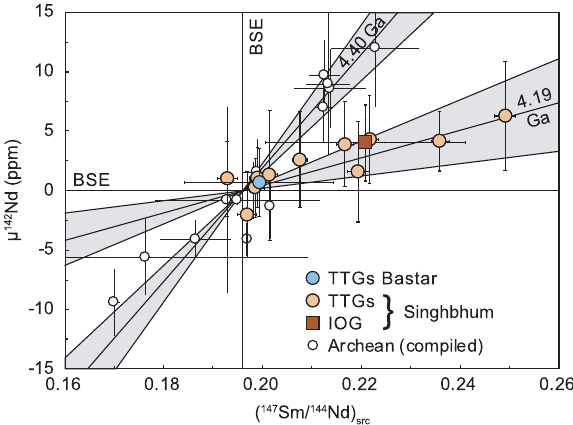
Fig. 1 Model ages of mantle depletion. Isochron diagram showing the 142 Nd isotope composition of Bastar and Singhbhum samples against the ( 147 Sm/ 144 Nd) src ratio of their respective mantle sources. ( 147 Sm/ 144 Nd) src is obtained from two-stage isotope evolution modelling of coupled 146,147 Sm- 142,143 Nd systematics (Supplementary Methods). Additional data from Archaean cratons (open circles) mark the onset of global crust-mantle differentiation at 4.4 ± 0.03 Ga (references in the text). Grey-shaded envelopes mark model age uncertainties. Error bars are 2 SE for single analyses and 2 SD for replicated analyses (Supplementary Data 1). Reference lines for bulk silicate Earth (BSE) are shown for context.